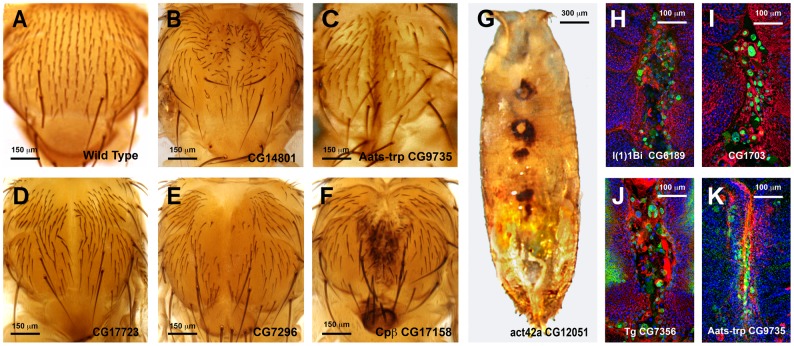
Thorax fusion phenotypes.
A to G) Thorax adult phenotypes grouped in different categories resulting from RNAi interference in the expression of selected genes. UAS-RNAi transgenes were expressed in the presumptive central area of the thorax with a Pnr-Gal4 driver. A) Wild Type adult. It shows a canonical midline fusion of the thoracic hemisegments and perfect patterning of sensory bristles B) Interference with CG14801 expression (Class 1TC phenotype) results in mirrored bristle polarity defects in the adult thorax. C) Interference with Aats-trp (CG9735) expression (Class 2TC phenotype) results in an excess of fusion with the hemithoraces collapsing at the midline. D) Interference with CG17723 expression (Class 3TC phenotype) results in a weak thorax cleft. E) Interference with CG7296 expression (Class 4TC phenotype) results in an intermediate thorax cleft. Some bristle defects are also observed. F) Interference with cpβ expression (Class 5TC phenotype) results in a big thorax cleft and scutellum abnormalities. G) Interference with Act42a (CG12051) expression (Class 6TC phenotype) results in pupal lethality and failure of discs eversion and/or fusion. Necrotic areas are found along the dorsal midline of an uneverted pupae. H to K) Expansion and fusion of imaginal discs are driven by leading edge cells, which extend long filopodia and accumulate an actin cable at the front edge. The JNK signaling pathway is activated in the leading edge cells during the fusion process. 7–7.5 h APF thoraces stained with Phalloidin (actin—red), DAPI (nuclei—blue) and Anti-LacZ (puc expression—Green). are shown. Anterior is up. H) Dorsal view of the thoracic area of a pupa which has failed to properly close upon downregulation of l(1)1Bi (CG6189) expression (Class 5TC). Phalloidin staining shows loss of actin accumulation or filopodia extensions in the leading edge of the discs, while puc-expressing cells are present along the full edge of both hemithoraces. I) Dorsal view of the thoracic area of a pupa showing irregular closure at the midline upon downregulation of CG1703 expression (Class 5TC). Phalloidin staining shows fusion defects, enlarged leading edge cells that seem to detach, which sustain strong puc expression. Picnotic nuclei are present in the scutellum area. J) Dorsal view of the thoracic area of a pupa which has failed to fully close upon downregulation of tg (CG7356) (Class 4TC). Phalloidin staining points to a clumsy accumulation of actin, most evident anteriorly. Several cells at the leading edge detach and round up and puc expression is sustained at the thorax midline. K)
Aats-trp downregulation during thorax closure results in an excess of fusion (Class 2TC) that does not seem to affect actin accumulation or puc expression (dorsal thoracic area). Scale bars are indicated for each panel.